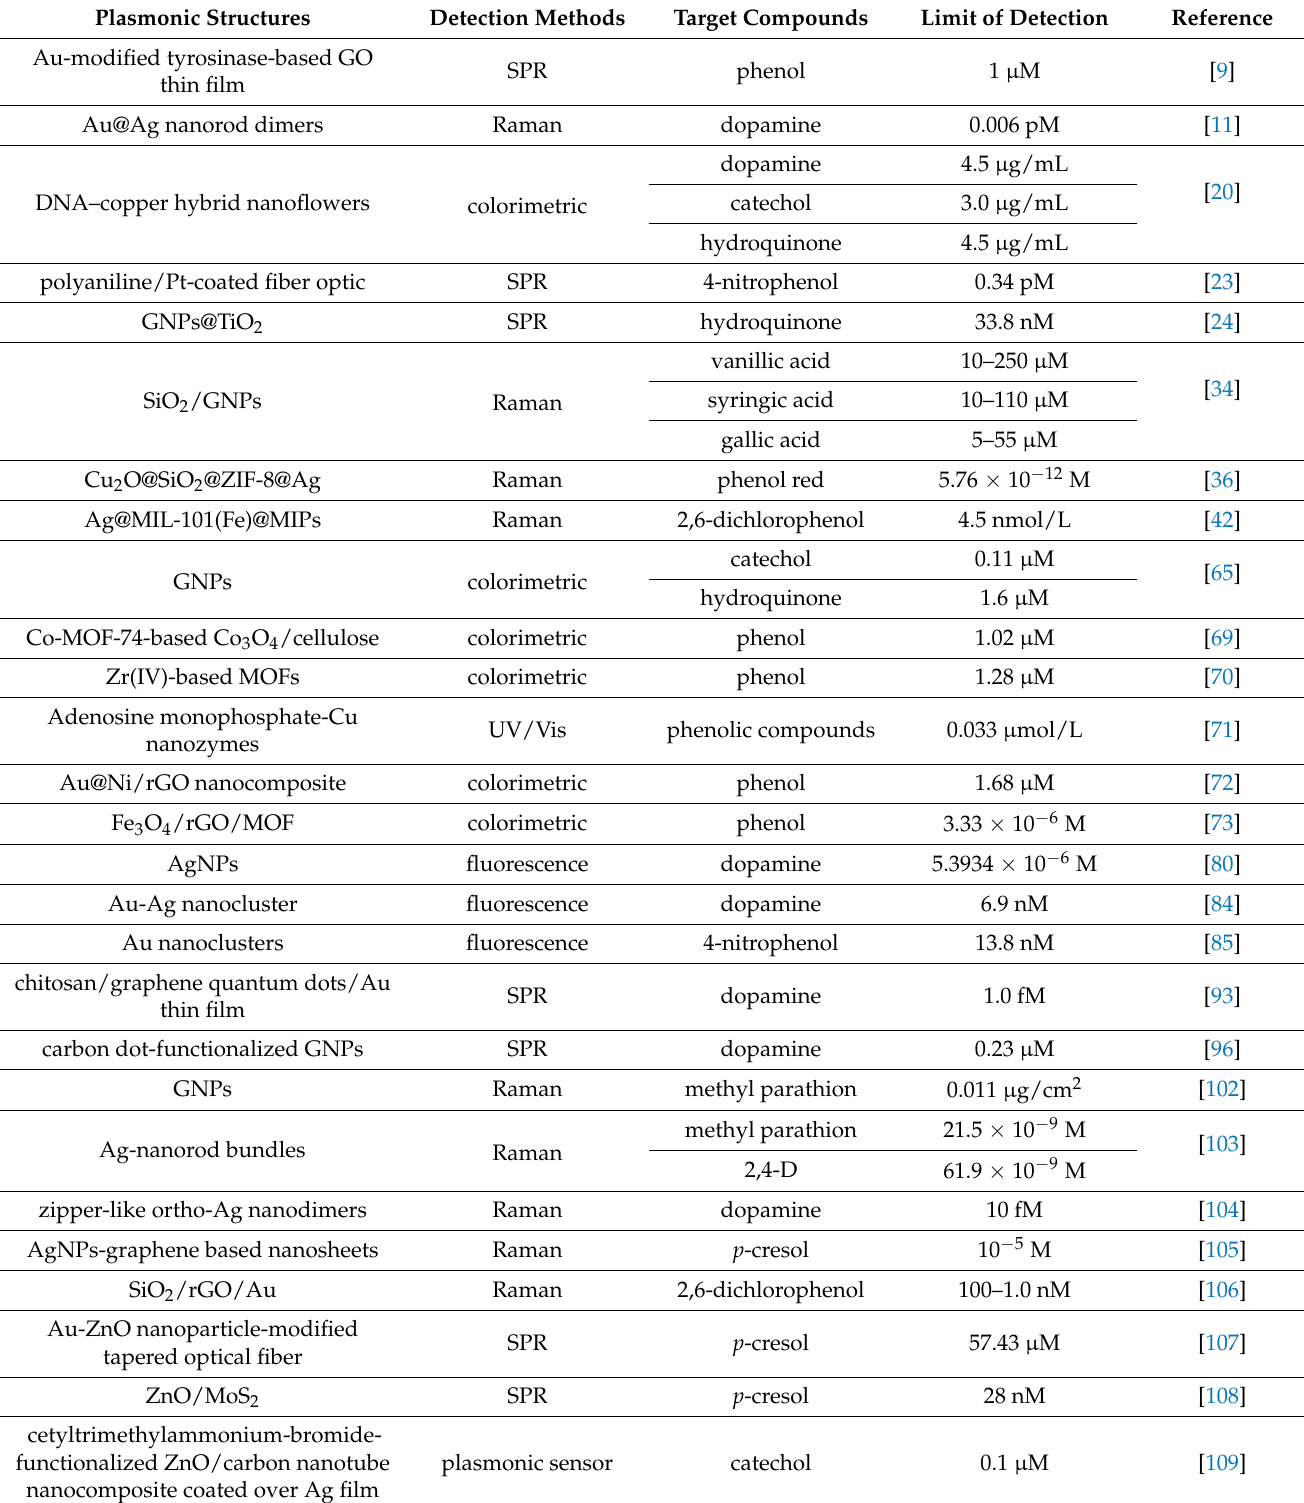
Table 1. Comparison of plasmonic resonance-based optical sensors for on-site detection of phenolic